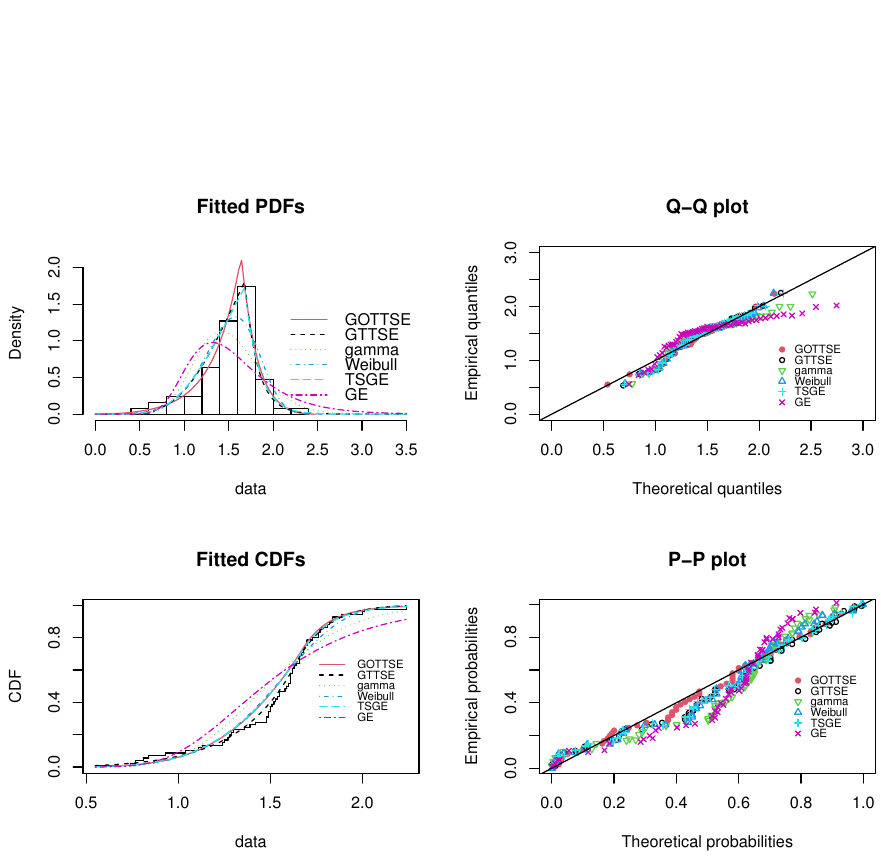
Figure 10 – Histogram, fitted pdfs, empirical and fitted cdfs, Q-Q plots and P-P plots of the GOTT- E distribution and other fitted distributions for the second data